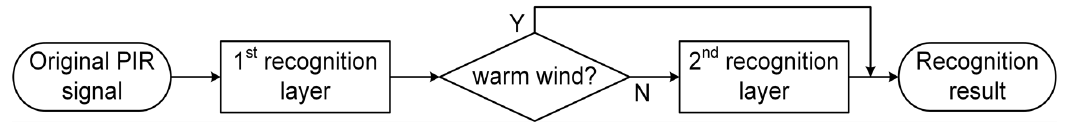
Figure 9. Two-layer recognition procedure for indoor intrusion detection.